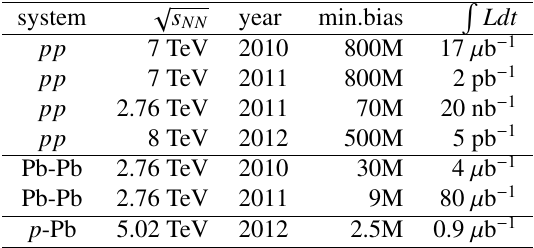
Table 1. Summary of data set recorded with ALICE.